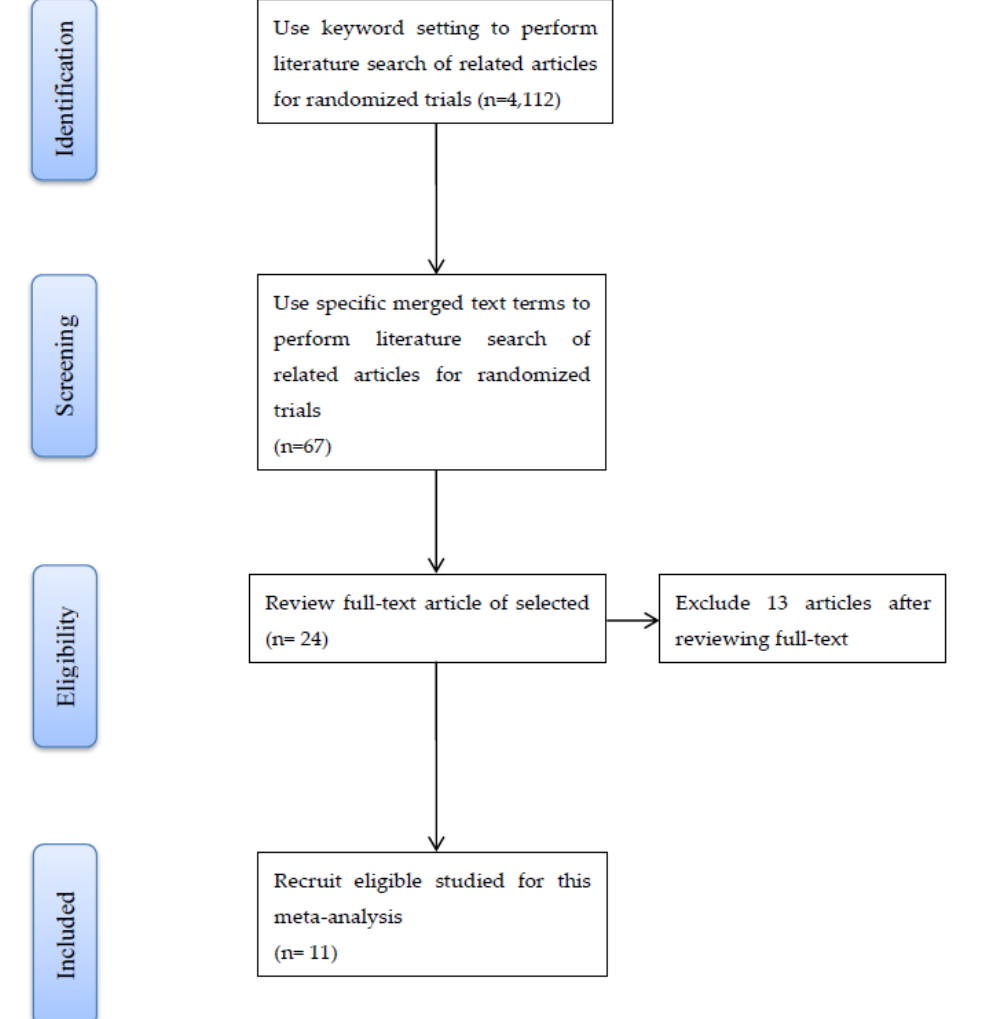
Figure 1. Flow chart of the selected eligible studies.